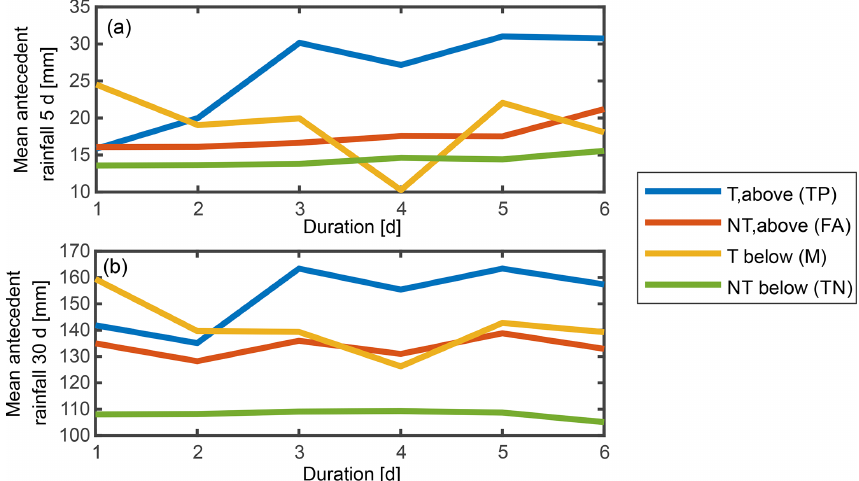
Figure 7. Mean antecedent rainfall over (a) 5 or (b) 30d before the date beginning of the event. All the rainfall events are separated into true positives (observed triggering events, T , which are above the cumulative rainfall-duration, ED, threshold), false alarms (observed non- triggering, NT, events which are above the ED threshold), misses (observed triggering events which are below the ED threshold), and true negatives (observed non-triggering which are below the ED thresholds), and the mean antecedent rainfall is computed for each of these for each rainfall event duration (1–6d). Results are based on the RDI rainfall dataset,